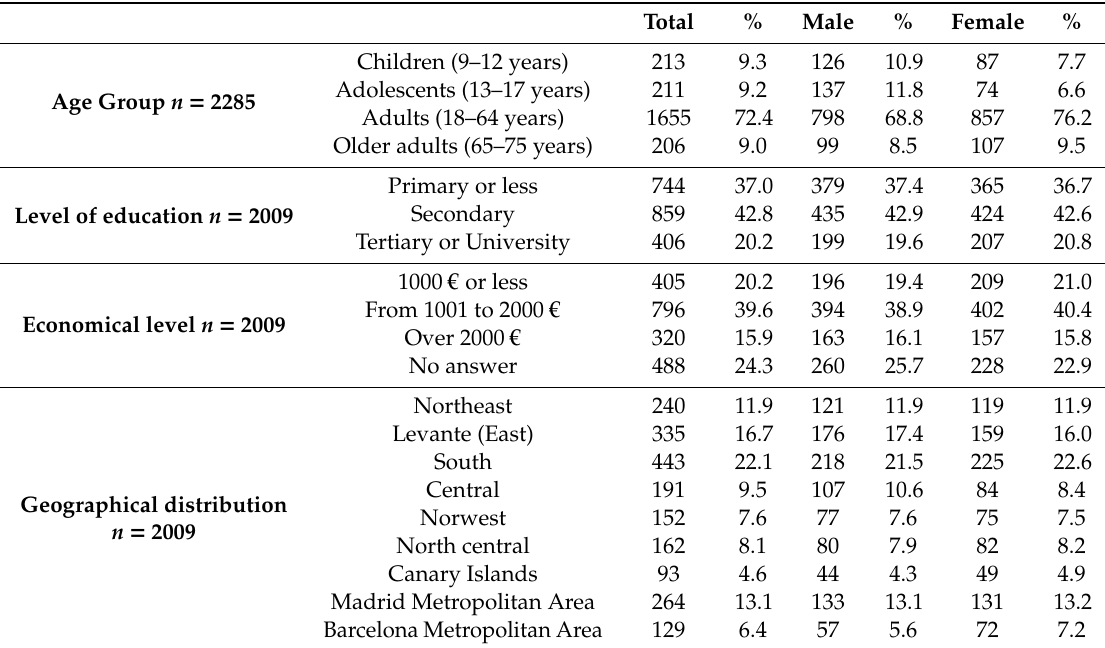
Table 1. Statistical description of the ANIBES study population sample (“Anthropometric data, macronutrients and micronutrients intake, practice of physical activity, socioeconomic data, and lifestyles in